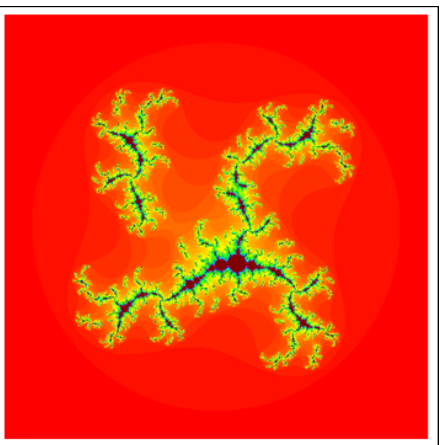
Figure 3. Fourth degree J-set via F-iterative scheme with image visual time = 31.18 s.